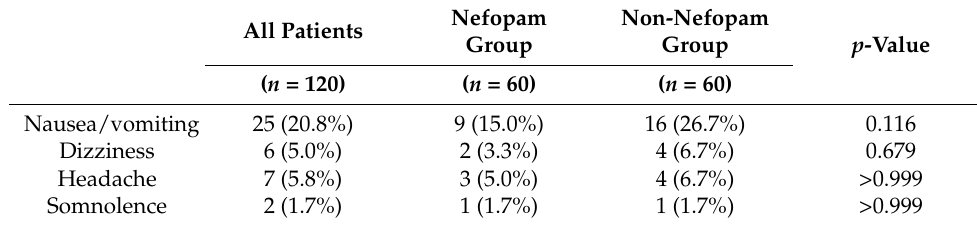
Table 5. Postoperative